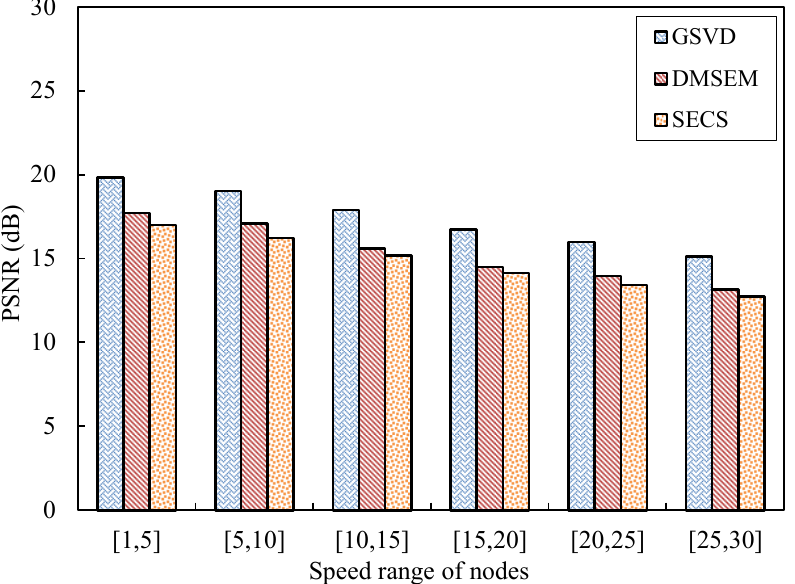
Figure 11. PSNR against various speed ranges of the